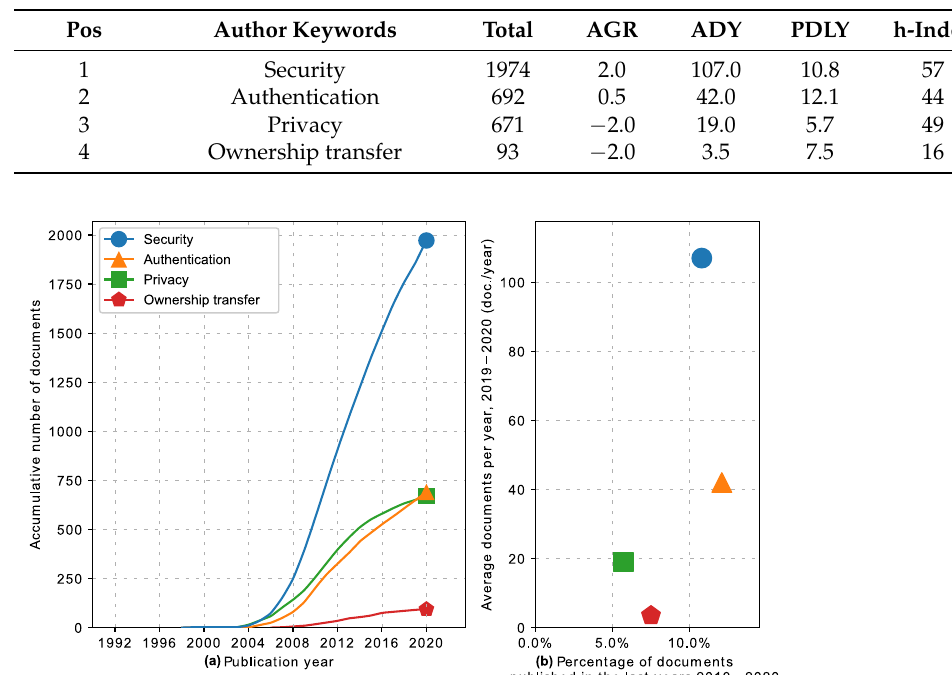
Figure 4. ( a ) Security and related topics, number of publications by year. ( b ) Average number of publications per year and percentage of documents published between